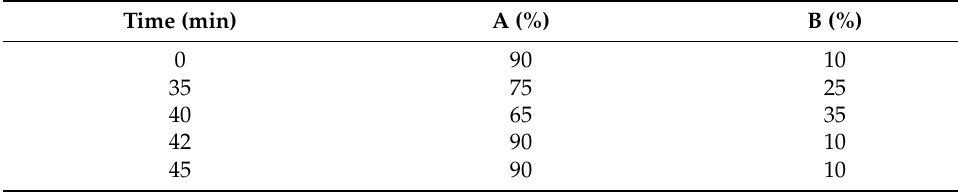
Table 1. The gradient elution of catechins and caffeine.